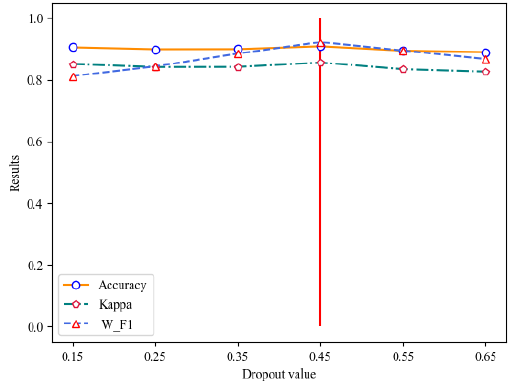
Figure 8. Selection of dropout value. Table 4. Selection of dropout value.